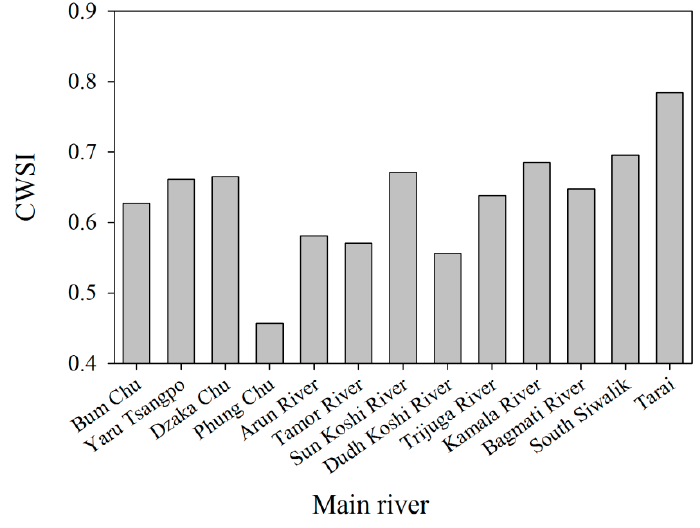
Figure 3. Drought degree in main rivers from Koshi River Basin (KRB).